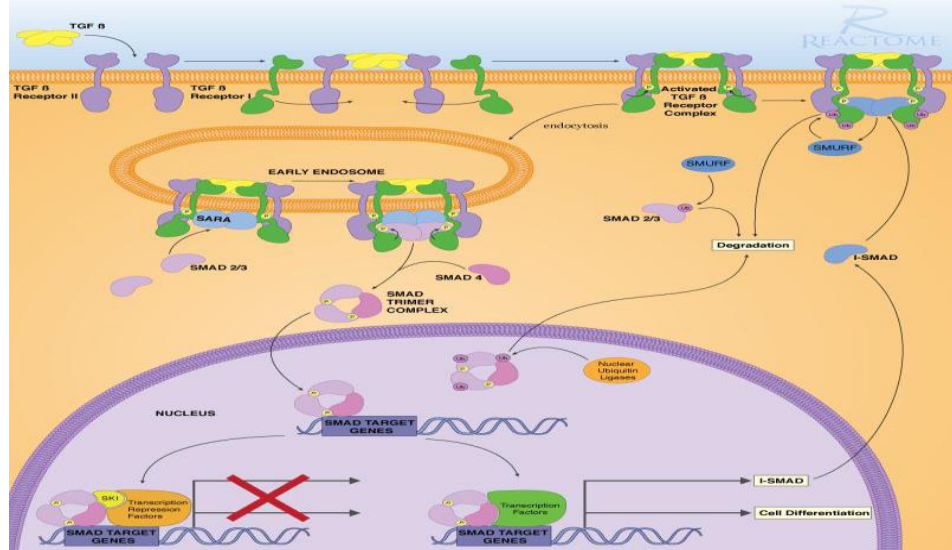
Figure 2. TGFβ-induced Smad signaling, created via Reactome and KEGG bioinformatic data ba- ses.